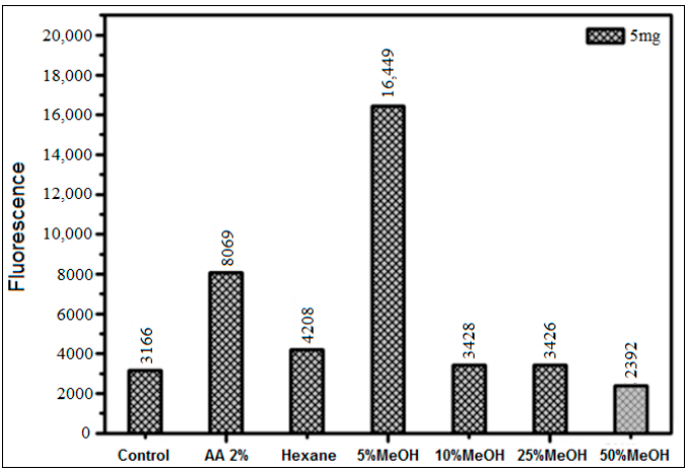
Figure 10. Inhibition of AGEs formation using 5 mg of various fractions obtained by Solid Phase Extraction SPE C18 columns of the methanol extract of HS leaves, measured in the glucose assay (37 °C) only in the presence of XO enzyme in pure phosphate buffer (pH = 6.6), with incubation for 48 h.